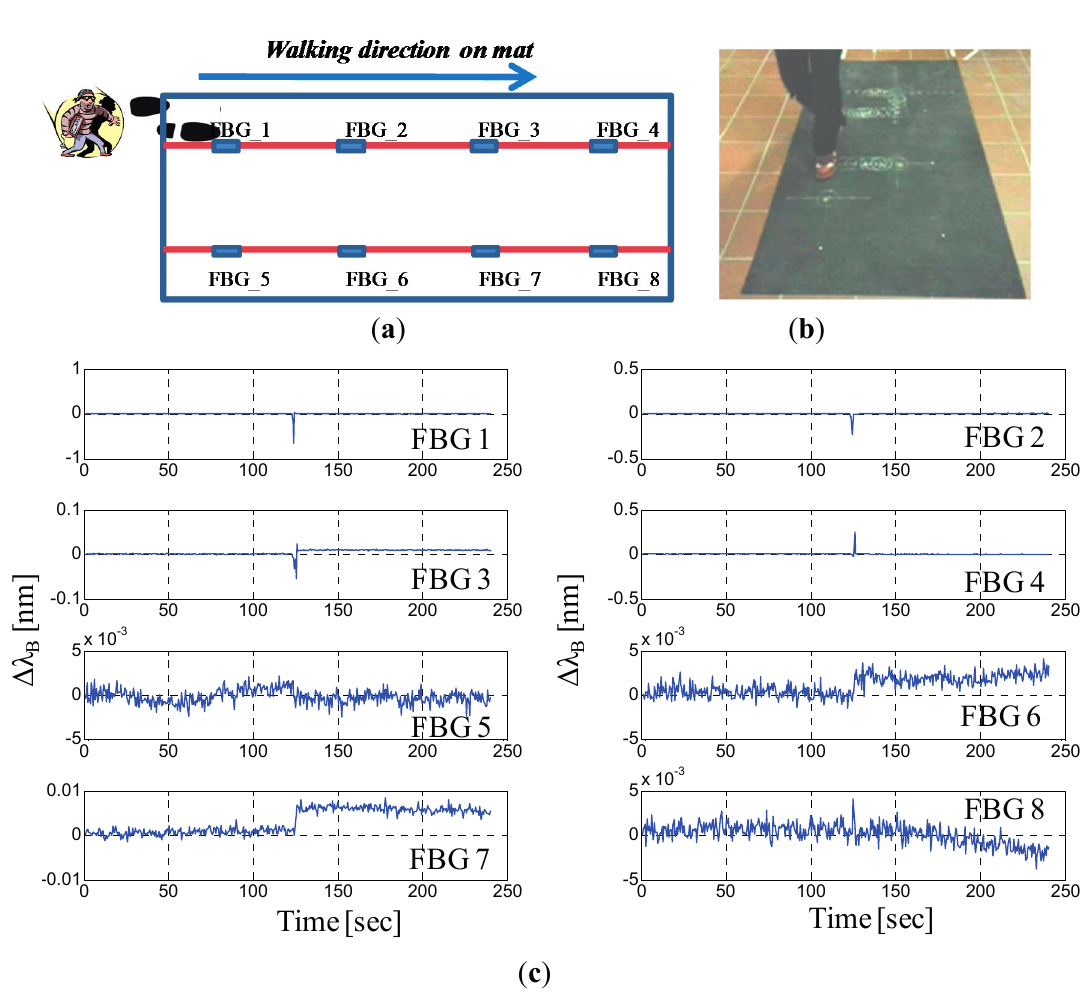
Figure 8. ( a ) Schematic of the intruder’s crossing pattern; ( b ) Photo of the walking test on the mat; ( c ) Bragg wavelength shift versus